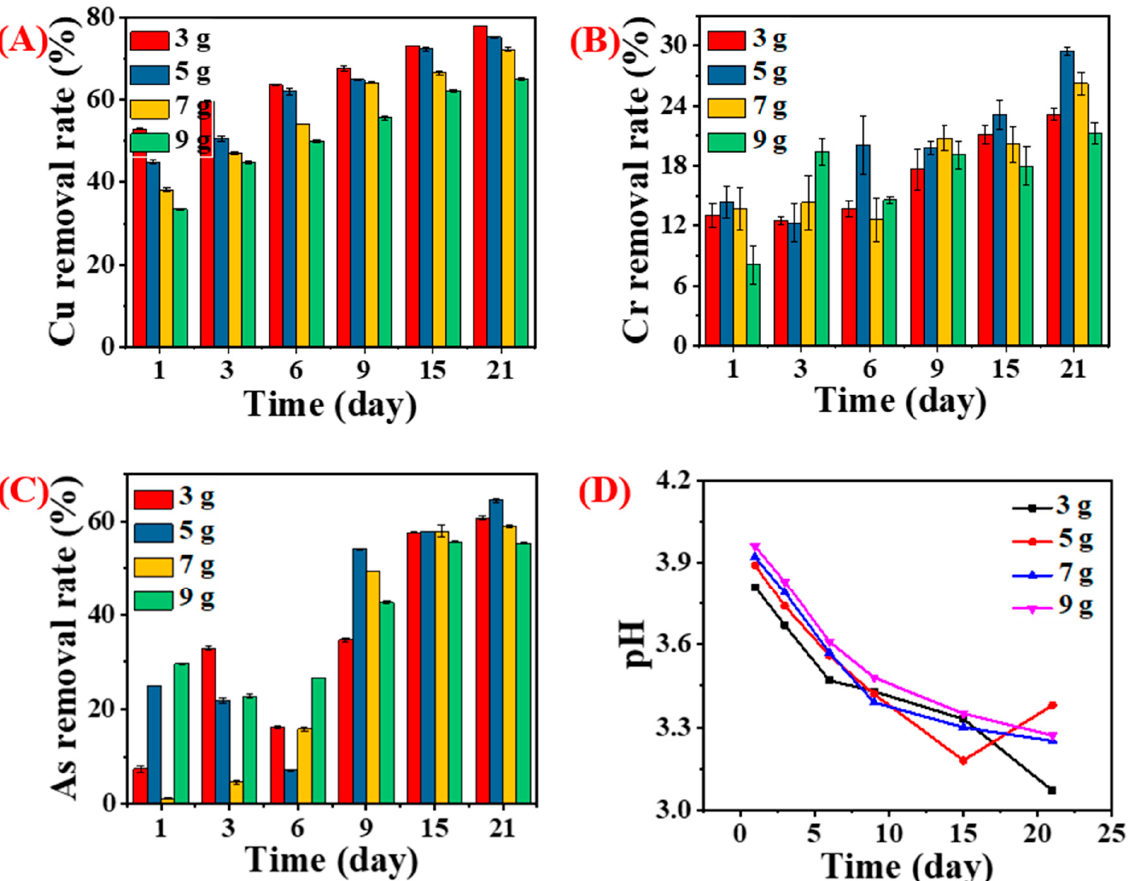
Figure 8. Removal rate of Cu ( A ), Cr ( B ), and As ( C ) from CCA-treated wood by Y. lipolytica (OD 600nm = 0.6) with different wood contents; pH of the fermentation medium with varying contents of CCA-treated wood ( D